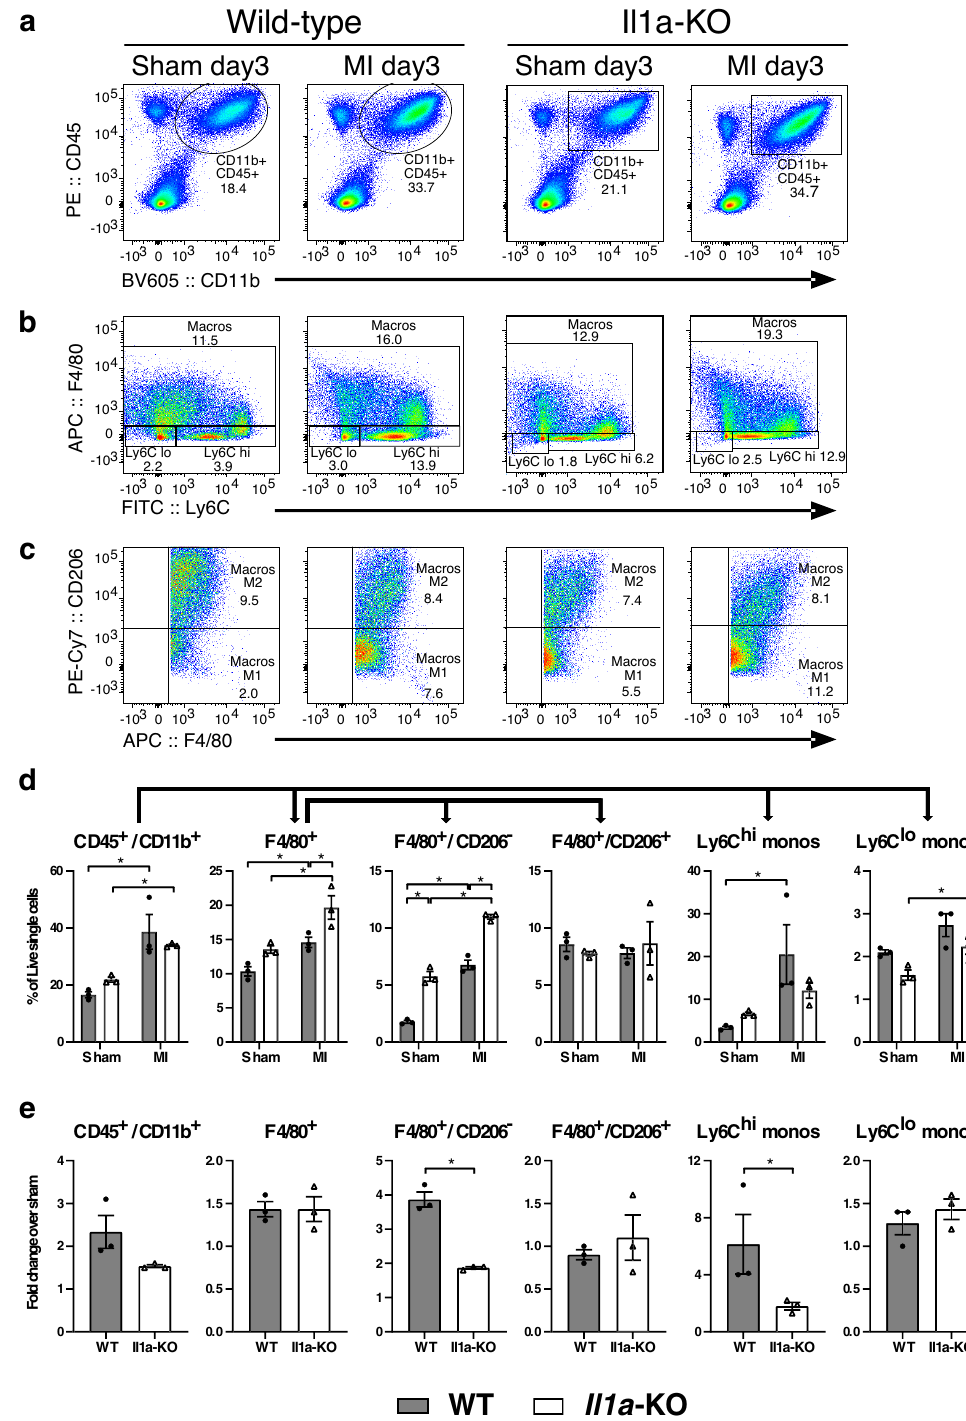
Figure 2. IL-1α-deficiency decreases myocardial infiltration with inflammatory monocytes after MI. Hearts from IL-1α WT and KO mice were obtained 3 days after MI or sham surgery for FACS analysis. Cells expressing the myeloid lineage marker CD45 + /CD11b + were sorted according to the expression of the macrophage marker F4/80. F4/80 − monocytes were sorted according to Ly6C expression into pro- (Ly6C hi ) and anti-inflammatory (Ly6C lo ) monocytes. F4/80 + macrophages were sorted according to CD206 into F4/80 + /CD206 − pro- inflammatory (M1) and F4/80 + /CD206 + anti-inflammatory (M2) macrophages. ( a – c ) Representative FACS analysis (one animal/group) of ( a ) CD45 + /CD11b + cells, ( b ) F4/80 + , F4/80 − /Ly6C hi and F4/80 − /Ly6C lo cells, ( c ) F4/80 + /CD206 − and F4/80 + /CD206 + cells, expressed as percentages of live cells. ( d ) Bar graphs showing the means ± sem of each cell population (in percentage of live cells) in n = 3 mice/group. ( e ) Owing to differences in cell populations under baseline conditions (sham), data are presented as fold change of each cell population in the myocardium after MI as compared to sham myocardium. N = 3/group. * p <